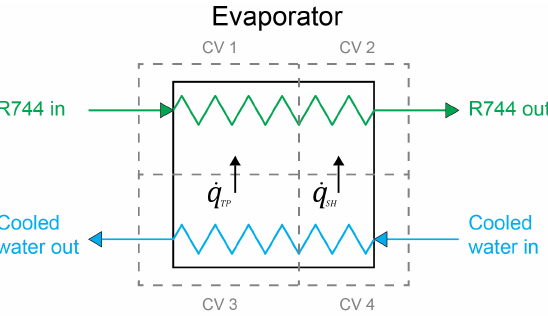
Figure A1. Evaporator component divided into four control volume